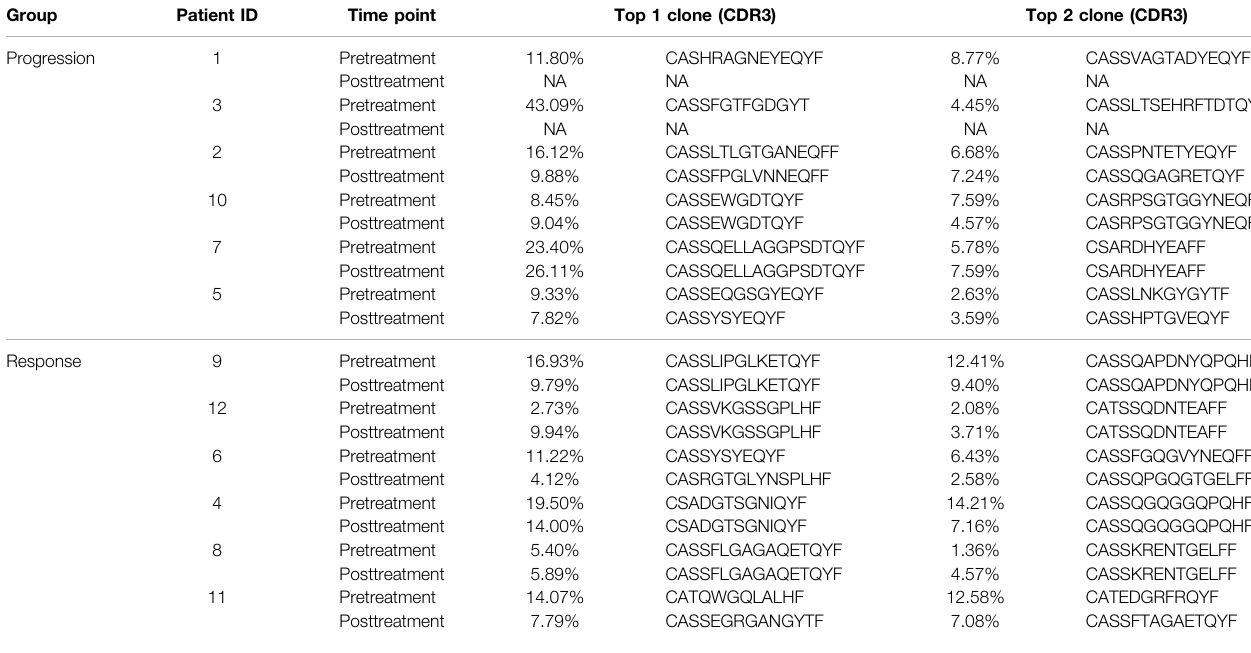
TABLE 2 | The Top two clones ’ amino acid sequences of complementary determination region 3 (CDR3) of TCR of each patient before and after treatment.